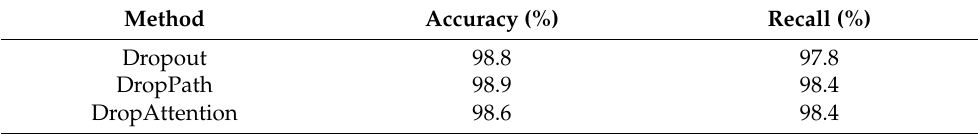
Table 4. Results of dropout experiments.